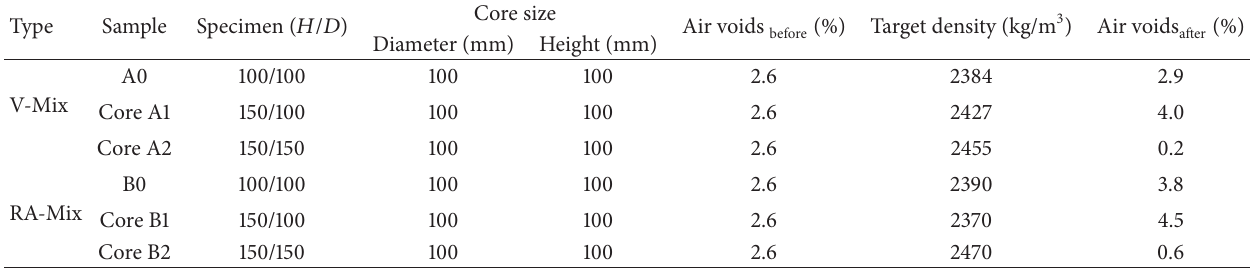
Table 3: Details of air voids content before and after trimming and